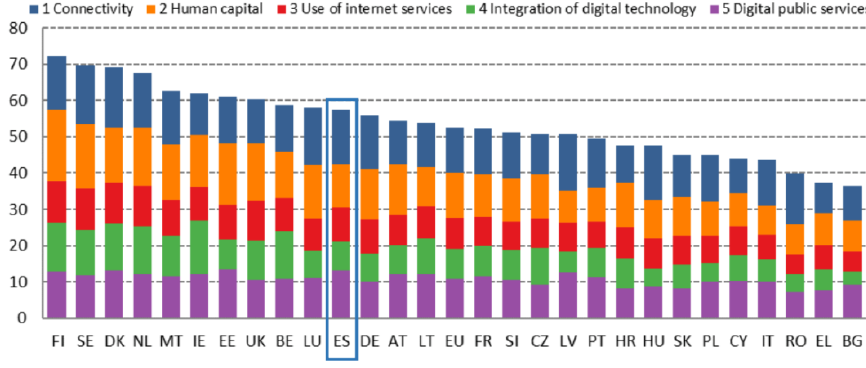
Figure 1: Digital Economy and Society Index 2020 (EU-28) (Source: European Commission